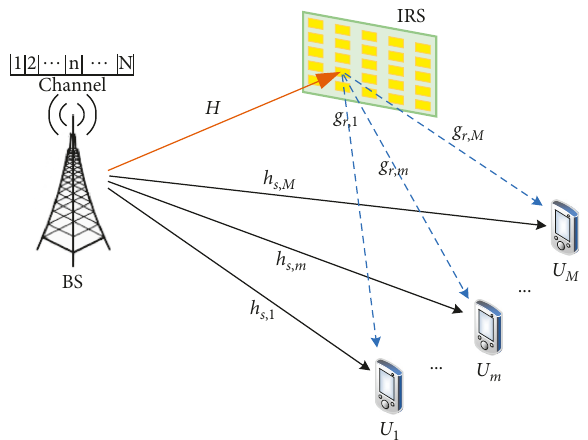
Figure 1: Block diagram of the system